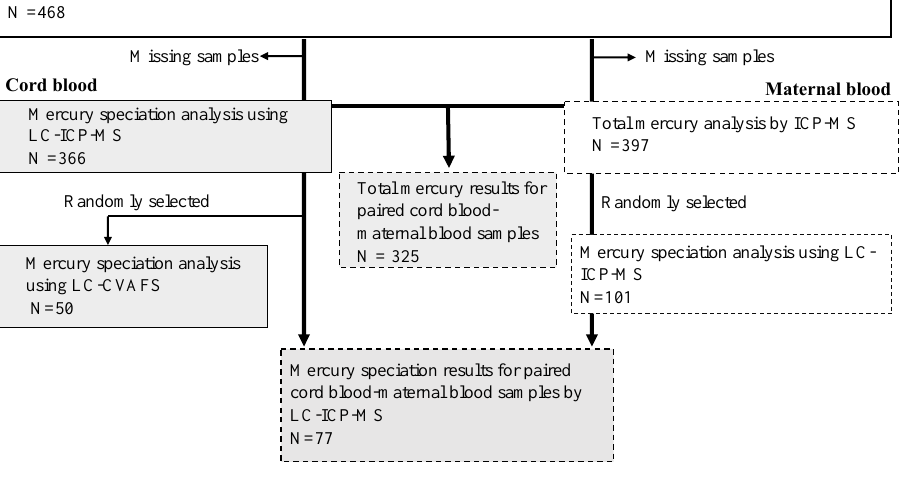
Figure 1. Analytical samples. Boxes in gray, with dotted lines, and in gray with dotted lines indicate cord blood, maternal blood, and paired maternal blood-cord blood samples, respectively. LC: liquid chromatography, ICP-MS: inductively coupled plasma mass spectrometry, CVAFS: cold vapor atomic fluorescence spectrometry.